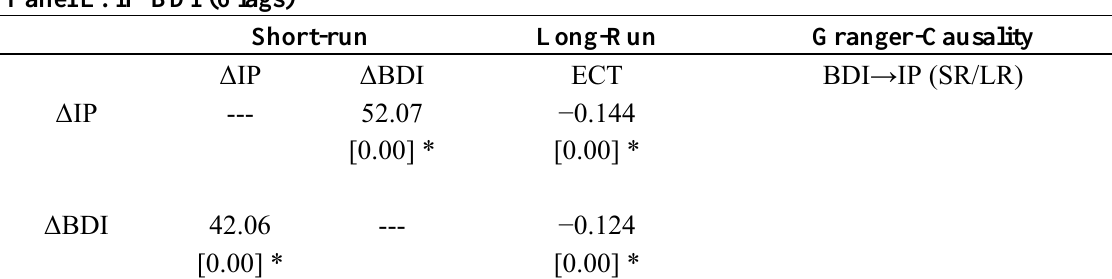
Panel E: IP-BDI (6